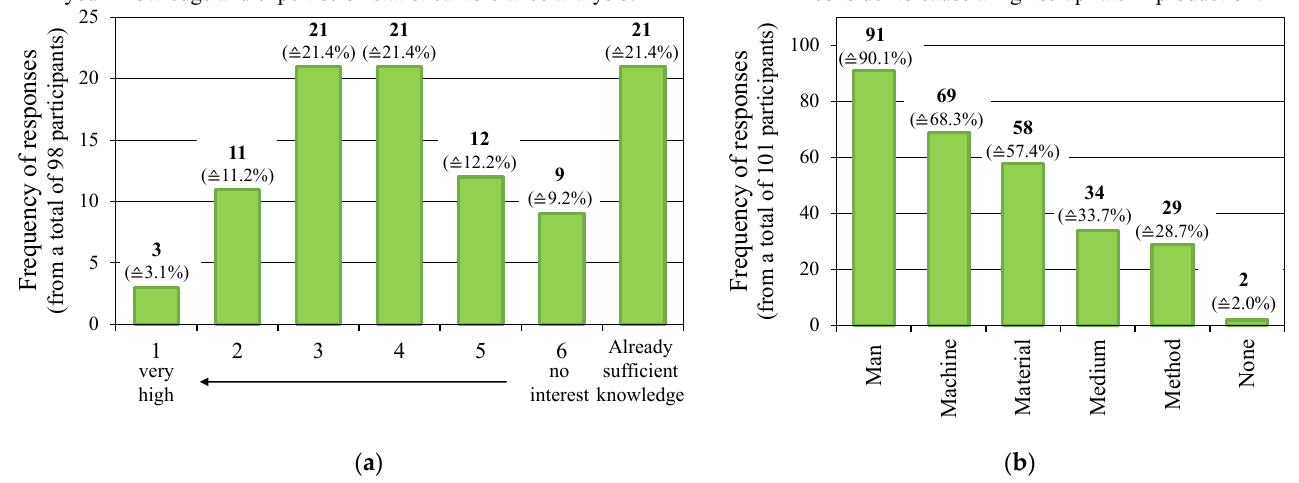
Figure 7. ( a ) Response of 98 participants to the (single-choice) question: “How great is your interest in further expanding your knowledge and expertise on statistical tolerance analysis?”; ( b ) response of 101 participants to the (multiple-choice) question: “What aspects do you consider to cause a high scrap rate in production?”.